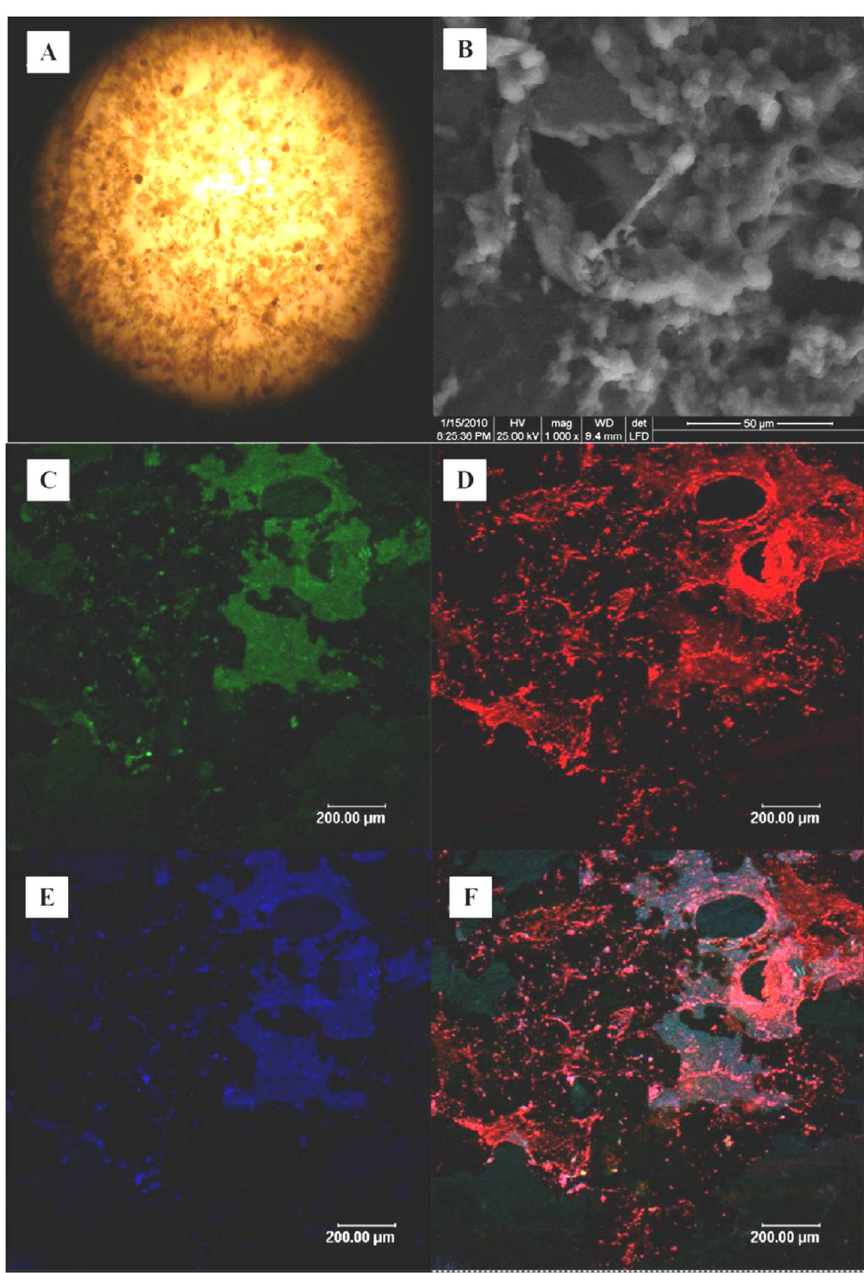
Figure 5. The photos of microbial flora analysis: ( A ) the microscope photos of seeding sludge; ( B ) the SEM images of bacteria on the 36th day; ( C , D ) the bacteria FISH analysis of ASBR on the 36th day: ( C ) Eubacteria; ( D ) Methanogens; ( E ) Acid-forming bacteria; ( F ) Superposition of three FISH images.